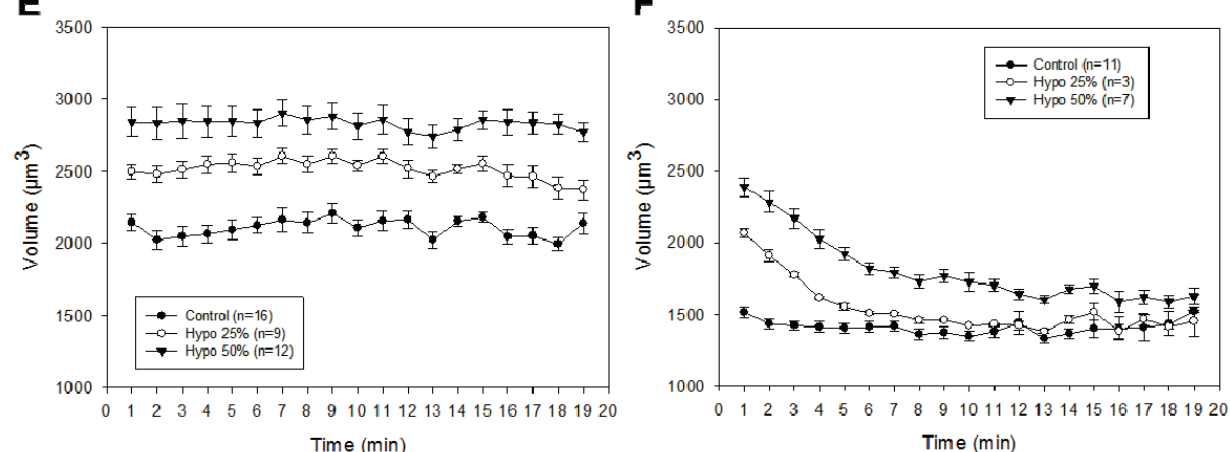
Figure 2. Cell volume monitoring during hypo-osmotic shocks. ( A ) Cell volume monitoring of MCF7 and MCF7/Doxo cells in normotonic conditions. The two graphs represent flow cytometry plots of the electronic volume (EV) vs. time, during the 20 min of the experiment; ( B ) Cell volumes after one minute of hypo-osmotic stress. Cell volumes were recorded by flow cytrometry before (control) or after one minute of a 50% hypo-osmotic shock (Hypo 50%). Data are presented as mean ± SEM; ( C ) Cell volumes monitoring in MCF7 and MCF7/Doxo cells during a hypo-osmotic shocks. The two flow cytometry plots represent the electronic volume (EV) of the cells subjected to a 50% hypo-osmotic stress during the 20 min. MCF7 cells ( left plot) increased their volume without any compensation phenomenon. After a significant volume increase, MCF7/Doxo cells ( right plot) retrieved their original volume; ( D ) Data extraction method. Nineteen equal gates of 1 min length have been created and applied to all samples. The mean cell diameter (Diam.) and of the mean cell volume (MCV) in each region have been extracted with the Cell Lab Quanta analysis software; ( E ) Cell volume monitoring of MCF7 under different conditions. Cell volumes of MCF7 have been recorded by flow cytometry in isotonic conditions (control) or during 25% or a 50% hypo-osmotic challenges; ( F ) Cell volume monitoring of MCF7/Doxo cells under different conditions. Cell volumes of MCF7 have been recorded by flow cytometry in isotonic conditions (control) or during 25% or a 50% hypo-osmotic challenges. *** p <